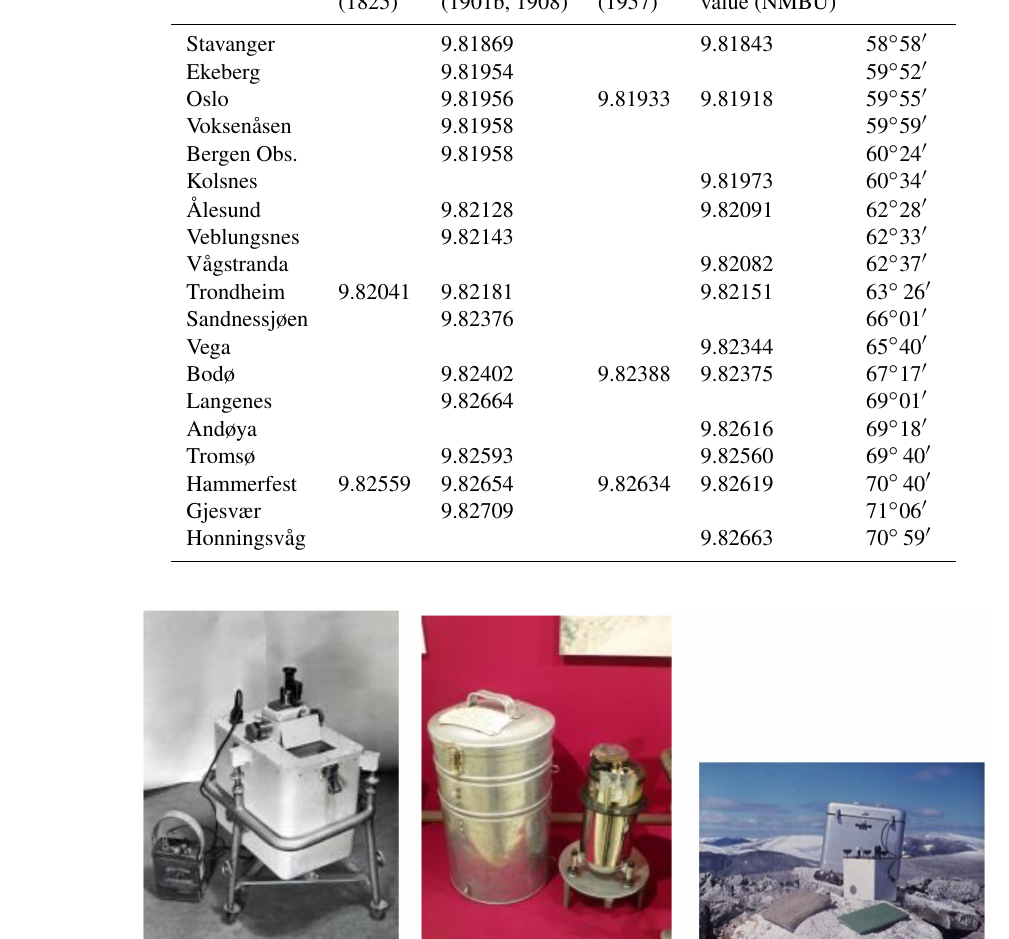
Three validated control stations and the improved